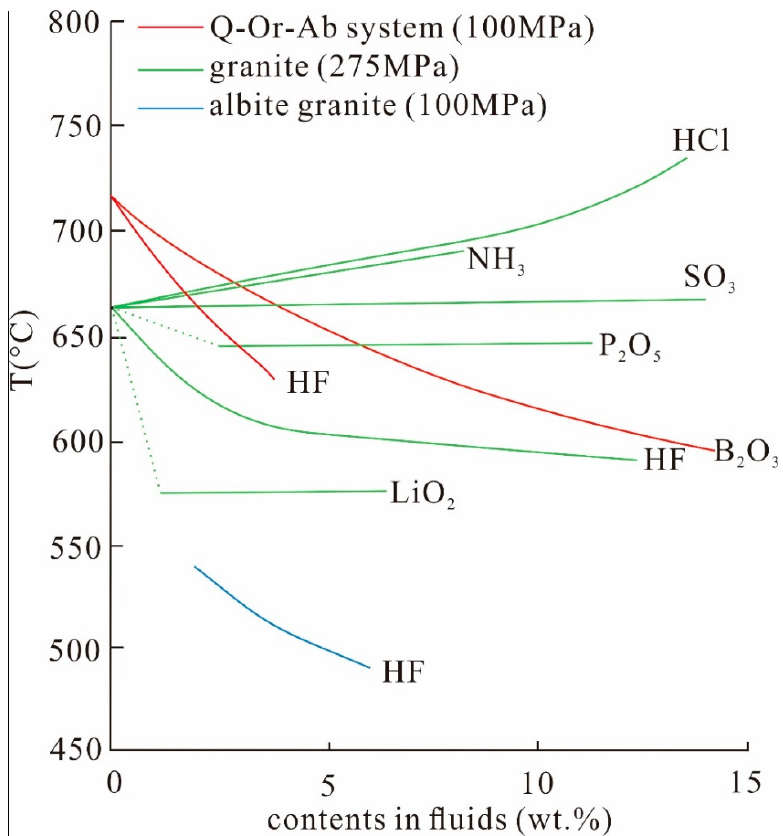
Figure 3. Effect of volatiles on the granite’s wet solidus curve, modified from refs [40,41,60,99].